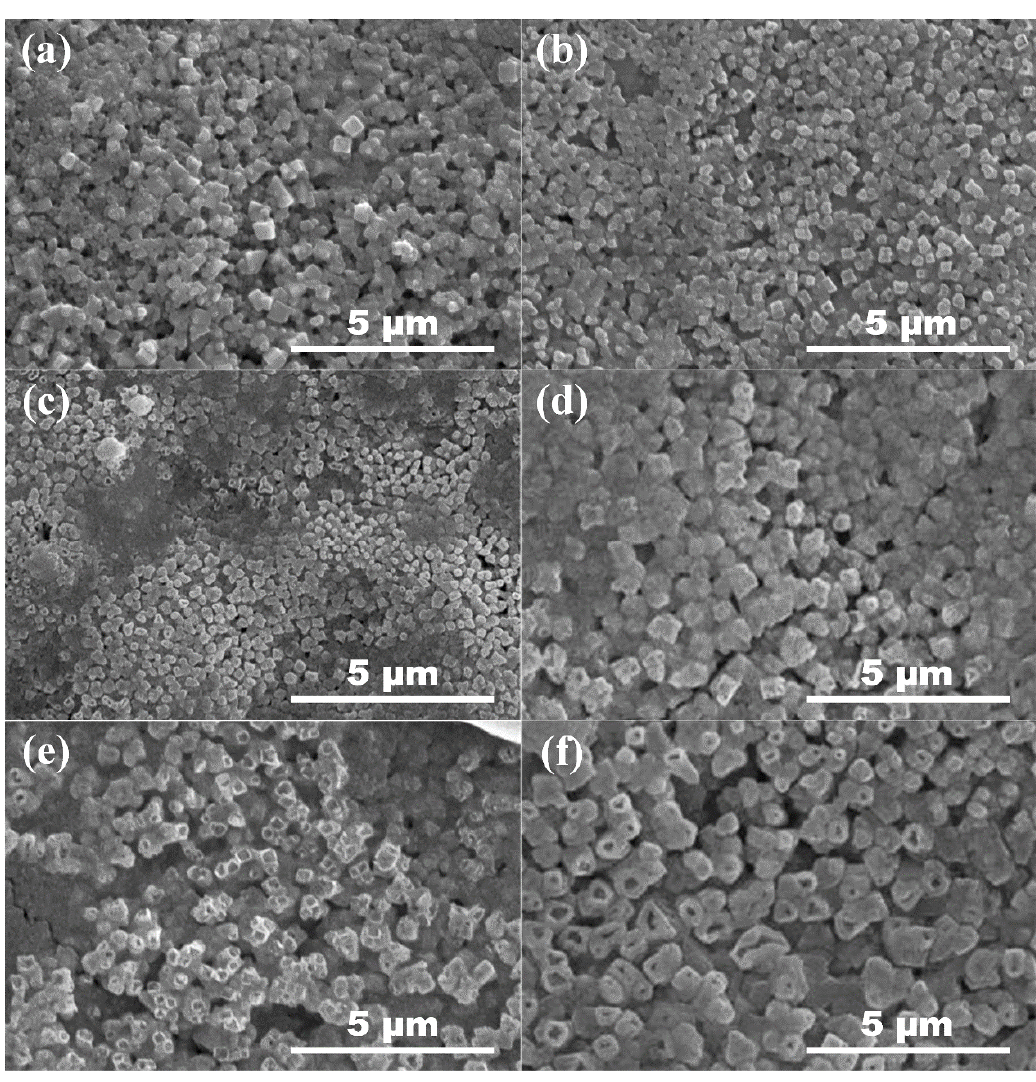
Figure 6. SEM images of undoped Cs 2 SnI 6 and Li + doped Cs 2 SnI 6 with different concentrations, ( a ) undoped, ( b ) Li + :Cs + = 1:20, ( c ) Li + :Cs + = 1:10, ( d ) Li + :Cs+ = 3:20, ( e ) Li + :Cs + = 1:5 and ( f ) Li + :Cs + = 1:4.